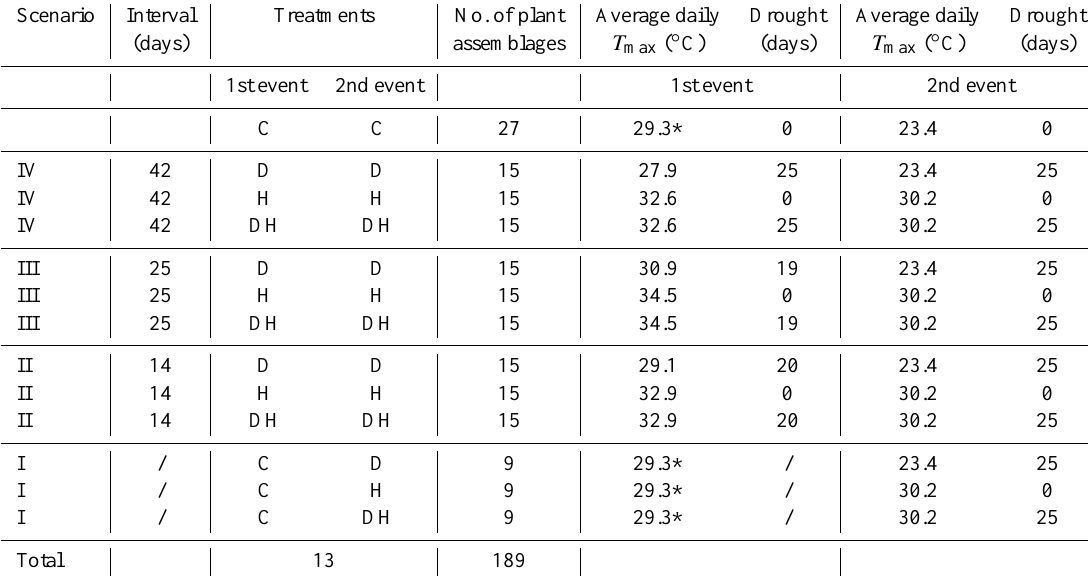
Table 1. Overview of different scenarios and treatments with number of replicate experimental plant assemblages per treatment, length of the drought events and the average daily maximal temperatures during the heat waves. C = control, D = drought, H = heat, and DH = drought + heat. * = highest average daily T max at the height of the canopy observed in the control plots during the entire period (DOY 153–225) preceding the second